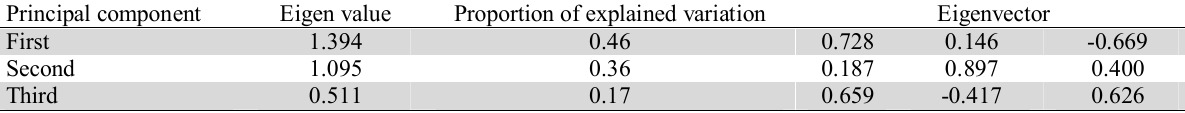
Experimental layout and estimates of β, σ 2 , SNR and SS for the responses (case study 2) Experimental layout Estimates from regression models Factors and their levels T r i a l